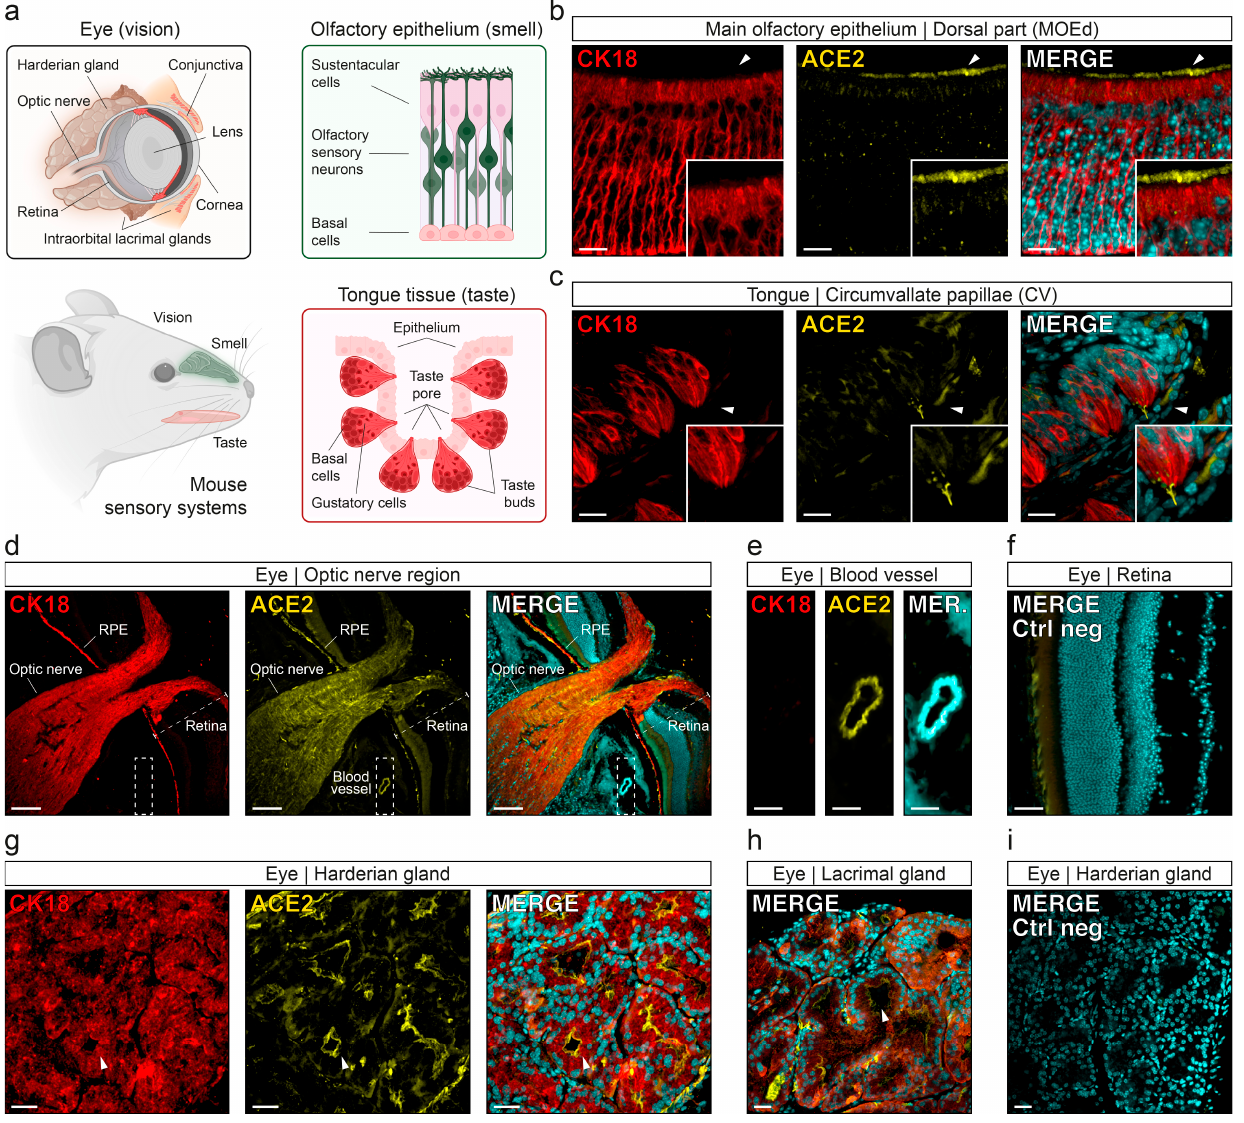
Figure 1. Co-expression of CK18/ACE2 in mouse sensory systems. ( a ) Schematic representation of a mouse head and its sensory organs and cells of interest. Illustrations are created with BioRender.com (in yellow) in the different mouse sensory systems. ( b ) In the MOE d , ACE2 is mainly expressed in